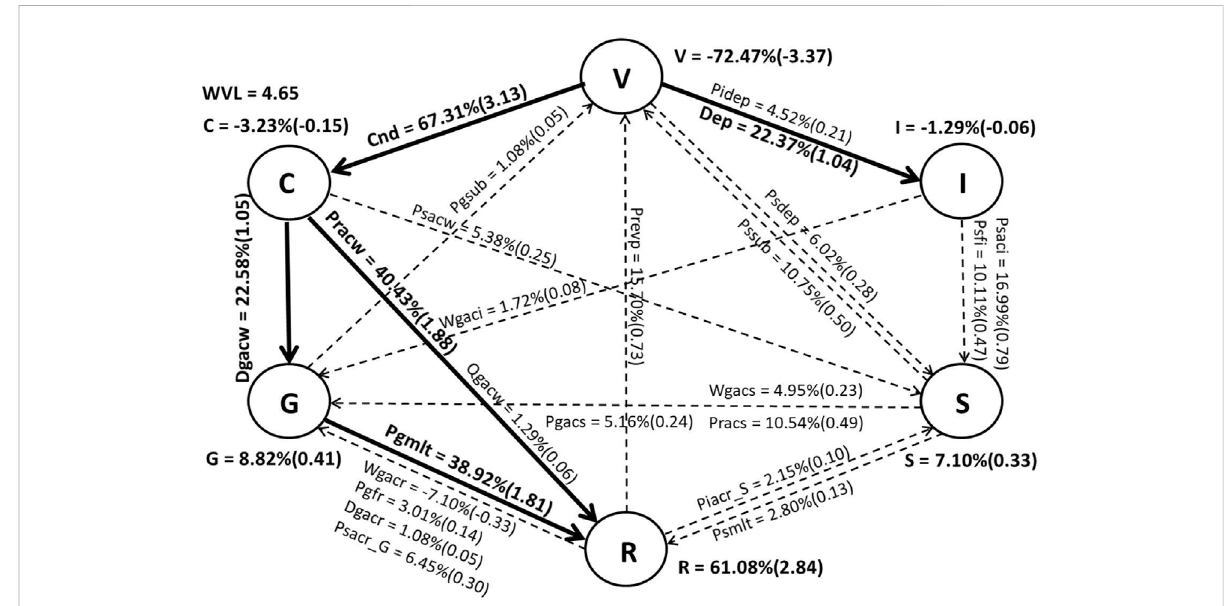
FIGURE 11 Microphysical fl owchart for the gale circle in the period of 1800 UTC 16 July to 0600 UTC 19 July 2014. On the right-hand side of each microphysical conversion process notation, the values outside the bracket are the ratio of the vertically cumulative conversion rate to total water vapor loss rate (WVL) (thick solid arrows show ratios greater than 20%, dotted arrows show ratios between 1% and 20%, and values less than 1% are omitted), while the values inside the brackets are the microphysical conversion rates (units: 10-6 Kg Kg − 1 s − 1 ). The sum of all the microphysical processtendenciesforeachspeciesisgivenbyV(watervapor),C(cloudwater),R(rainwater),I(cloudice),S(snow),andG(graupel)(duetothesmall order of magnitude, hail is